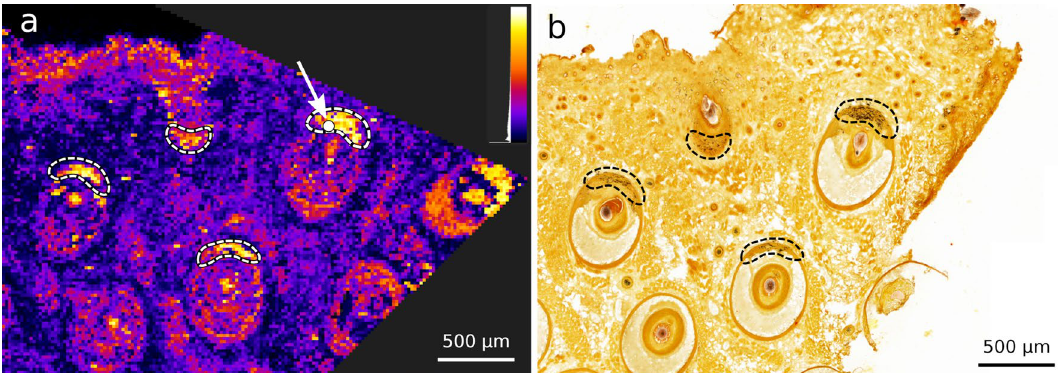
O v ( a ) with corresponding histology ( b ). The O v shows clear patterns at